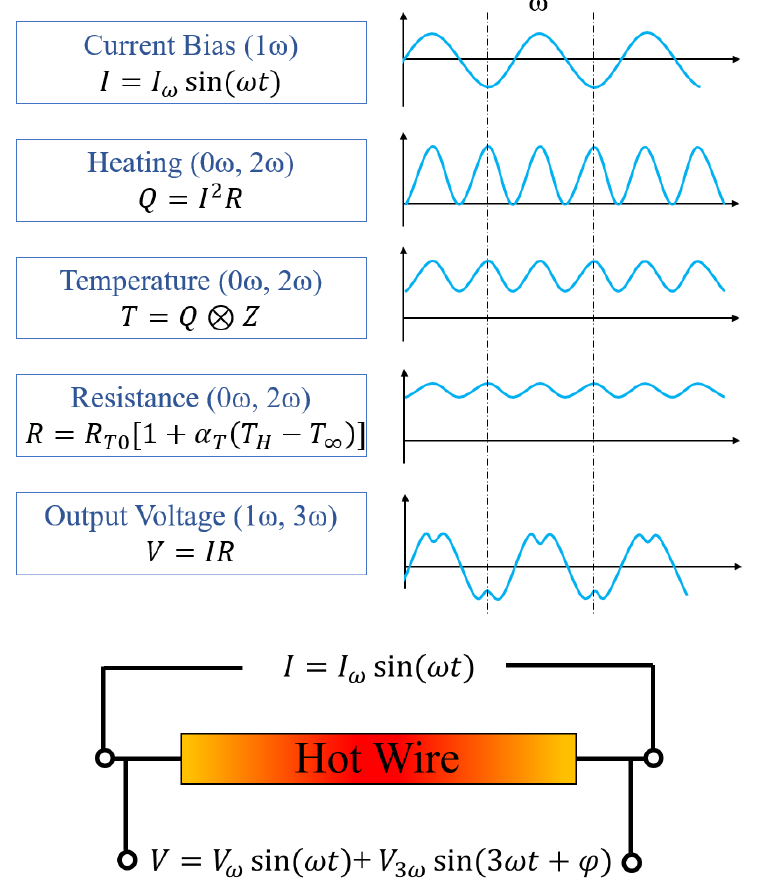
Figure 8. The relationships between sinusoidal excitation, heating and voltage measurement of the hot wire, used to help illustrate and understand the 3 ω technique.